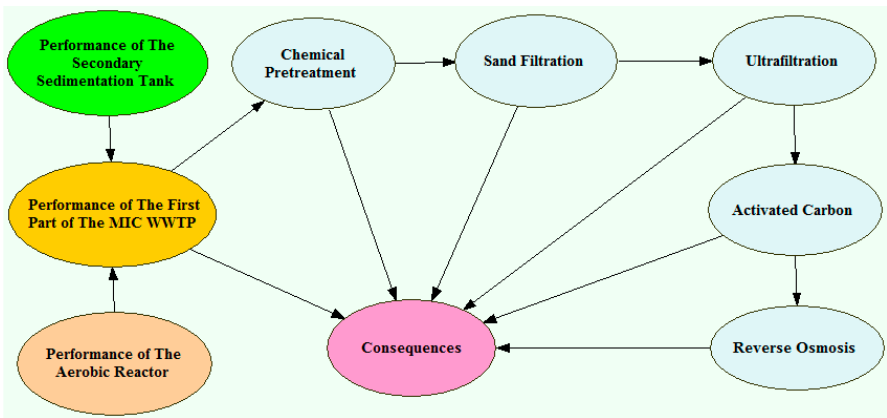
Figure 7. The DBN model of the MIC WWTP (part 2—Performance of the secondary sedimentation tank).